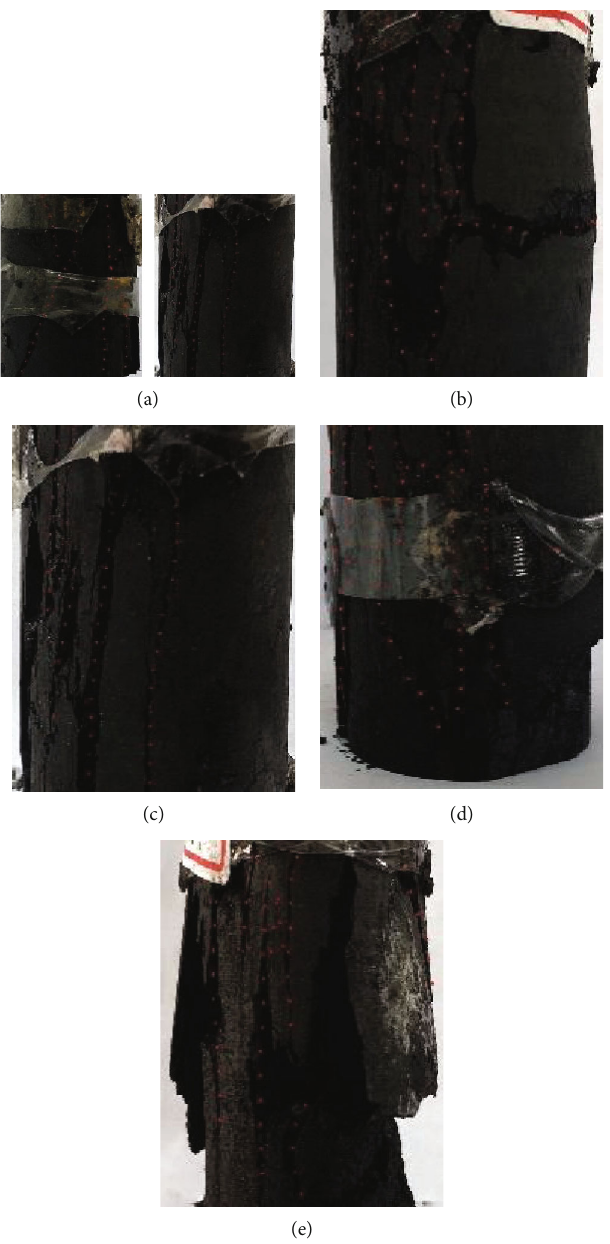
Figure 10: Local images of the broken states of coal samples with di ff erent moisture contents ((a) 16%; (b) 17%; (c) 20%; (d) 21%; (e)